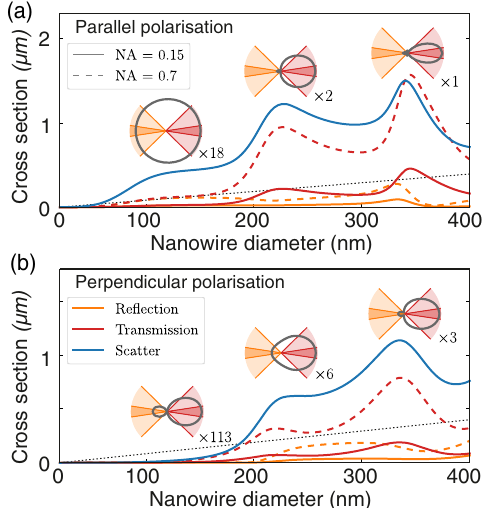
FIG. 6. Nanowire multipolar optical response: Mie resonances. Scattering cross sections for infinite SiC cylinders under plane- wave illuminations incoming from the left-hand side, for in- creasing nanowire diameters. The reflection, transmission, and scatter components are integrated in the backward, forward, and lateral angular segments, respectively. The total linear cross section can largely exceed the nanowire diameter (indicated by a black line) and varies rapidly with the nanowire diameter due to the Mie resonances. The nanowire optical response can be assimilated to a dipole for diameters smaller than approximately 100 nm, while its multipolar character must be taken into account for the nanowires employed in that work (130 and 160 nm in diameter). finesse), this nanowire should permit us to reach a single-